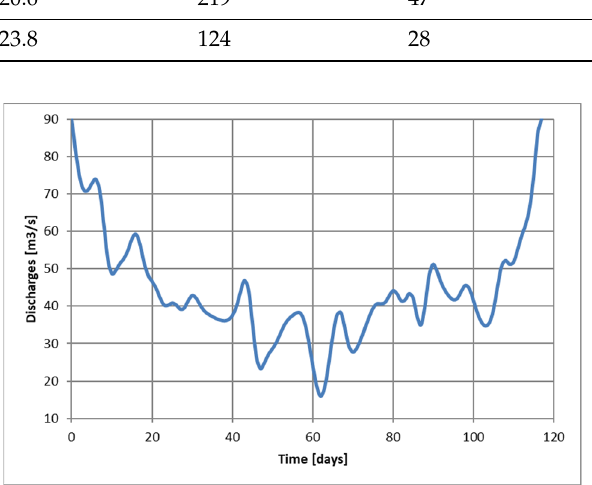
Figure 10. Synthetic drought hydrograph—Class 3.